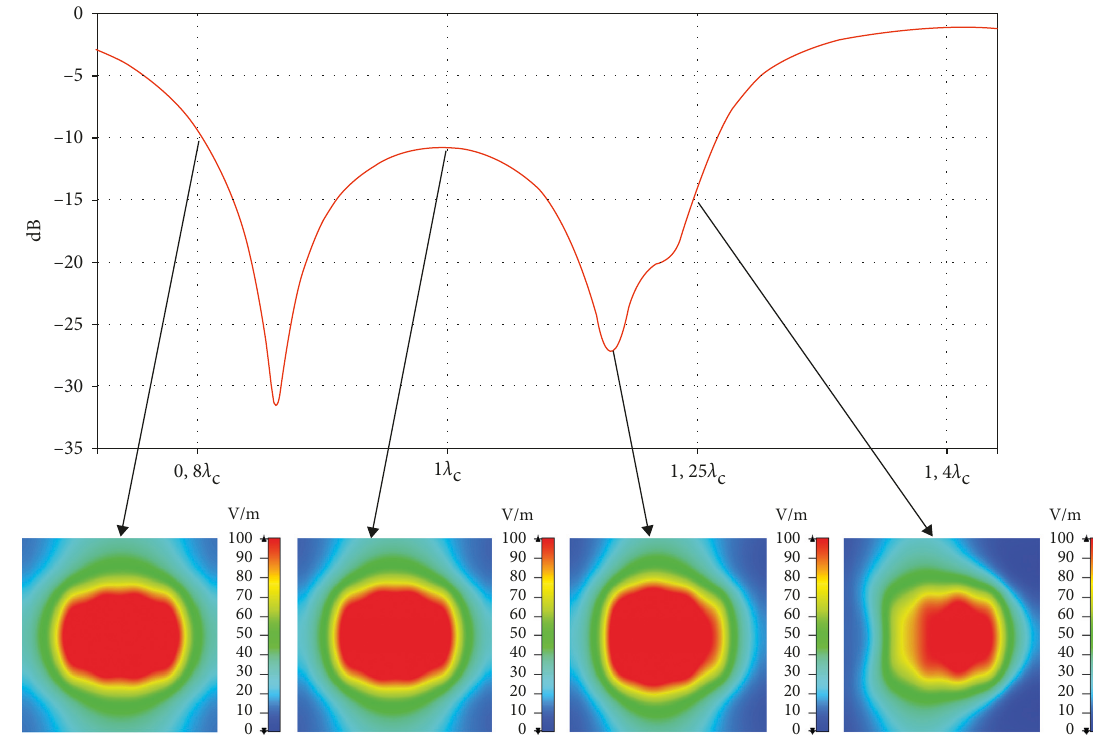
Figure 7: S 11 parameter vs frequency for a 41% bandwidth and E field cartographies for some frequencies.